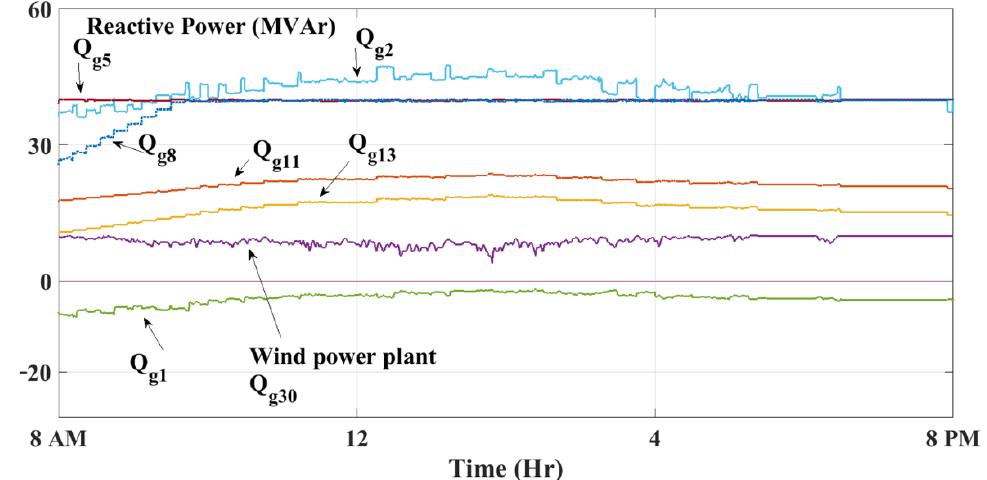
Figure 11. Reactive power generation from synchronous machines and the non-dispatchable 10 MW wind farm.